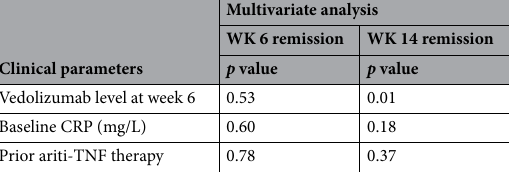
Table 6. Clinical parameters association with week 6 and 14 clinical remissions. CRP C reactive proteins, anti- TNF Anti-tumor necrosis factor.